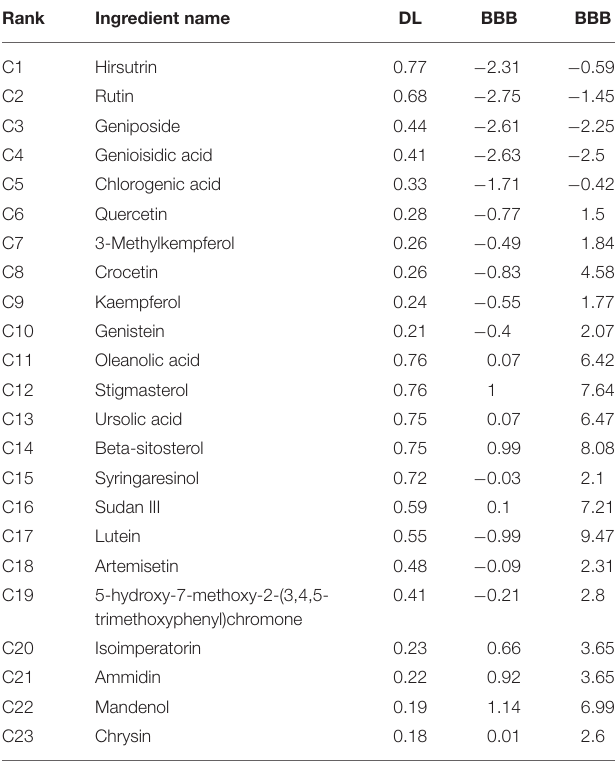
TABLE 1 | Twenty-three compounds derived from GJE that can target genes associated with both menopause and the ovary. Rank